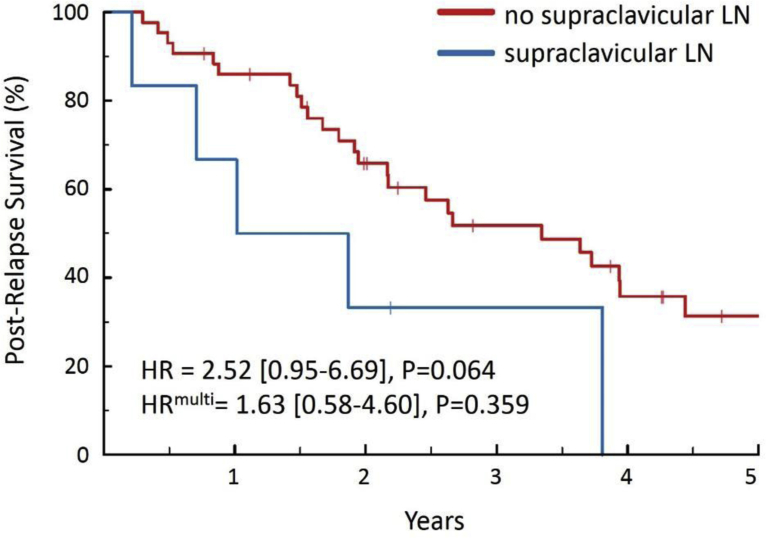
Postrelapse survival of isolated lymph node relapse ovarian carcinoma with and without supraclavicular lymph node involvementHollis et al. Clinical and molecular characterization of ILNR ovarian carcinoma. Am J Obstet Gynecol 2019.